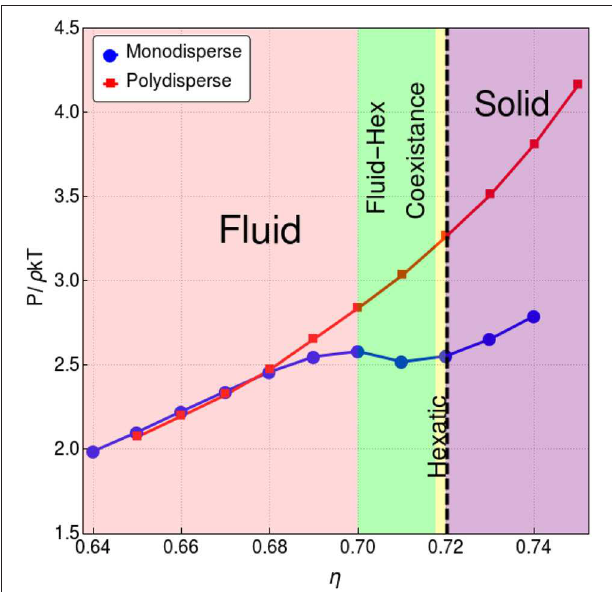
FIGURE 1 | Pressure vs. packing fraction in the studied region for monodisperse hard-disks (blue curve) and bidisperse hard-disks (red curve) as shown in the plot legend. For the case of monodisperse hard-disks, below η 0.7 the system is in the fluid phase (colored pink), between η ≈ η 0.7175 the fluid coexist with the hexatic phase (colored green). Above ≈ η 0.7175 the system is in a hexatic phase (colored yellow). At η ≈ second order phase transition from hexatic to solid occurs (marked with a dashed line), and above η 0.72 the system is in the solid phase (colored ≈ purple) ( Russo and Wilding, 2017). This plot was obtained from a simulation with N 2,500 hard-disks. =